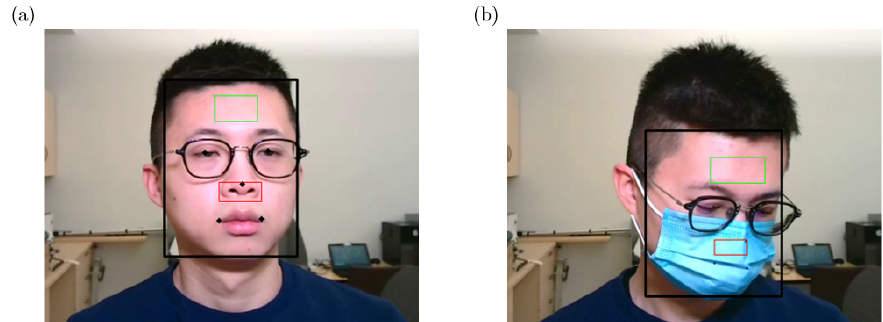
Figure 7. ( a ) Facial landmarks and partitions when the subject is looking at the camera. ( b ) Scenario when the subject is not looking at the camera and the ratio Face deflection reaches